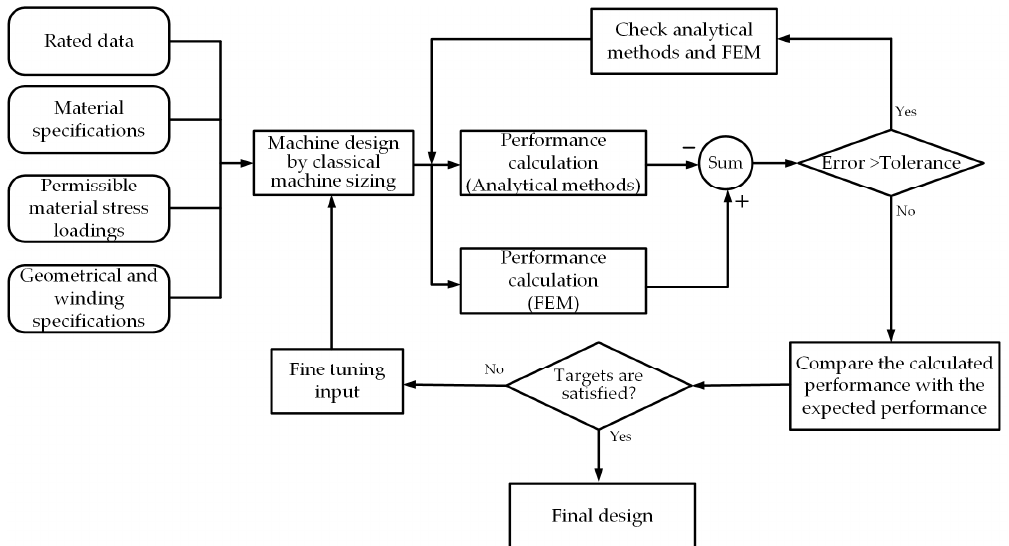
Figure 1. Flowchart for PMSM design in a CAD environment.